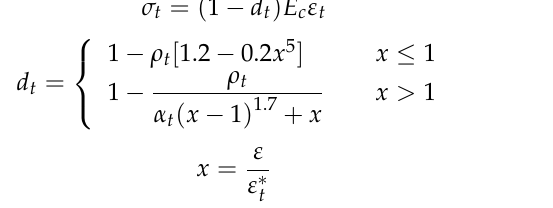
where, α t is the parameter value of the descending stage of the uniaxial stress ‐ strain curve for concrete, take 1.95;